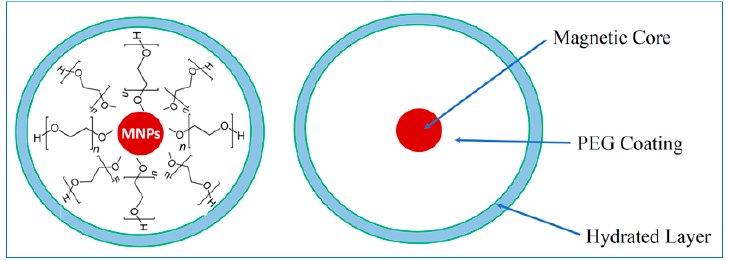
Figure 2. ( a ) XRD pa tt erns of the PEG-coated MNPs as a function of the concentration of PEG, ( b ) FT-IR spectra of the PEG-coated MNPs as a function of the concentration of PEG, ( c ) TGA thermo- grams of the PEG-coated MNPs as a function of the concentration of PEG, ( d ) the extent of coating of MNPs with PEG as depicted from their TGA thermograms.